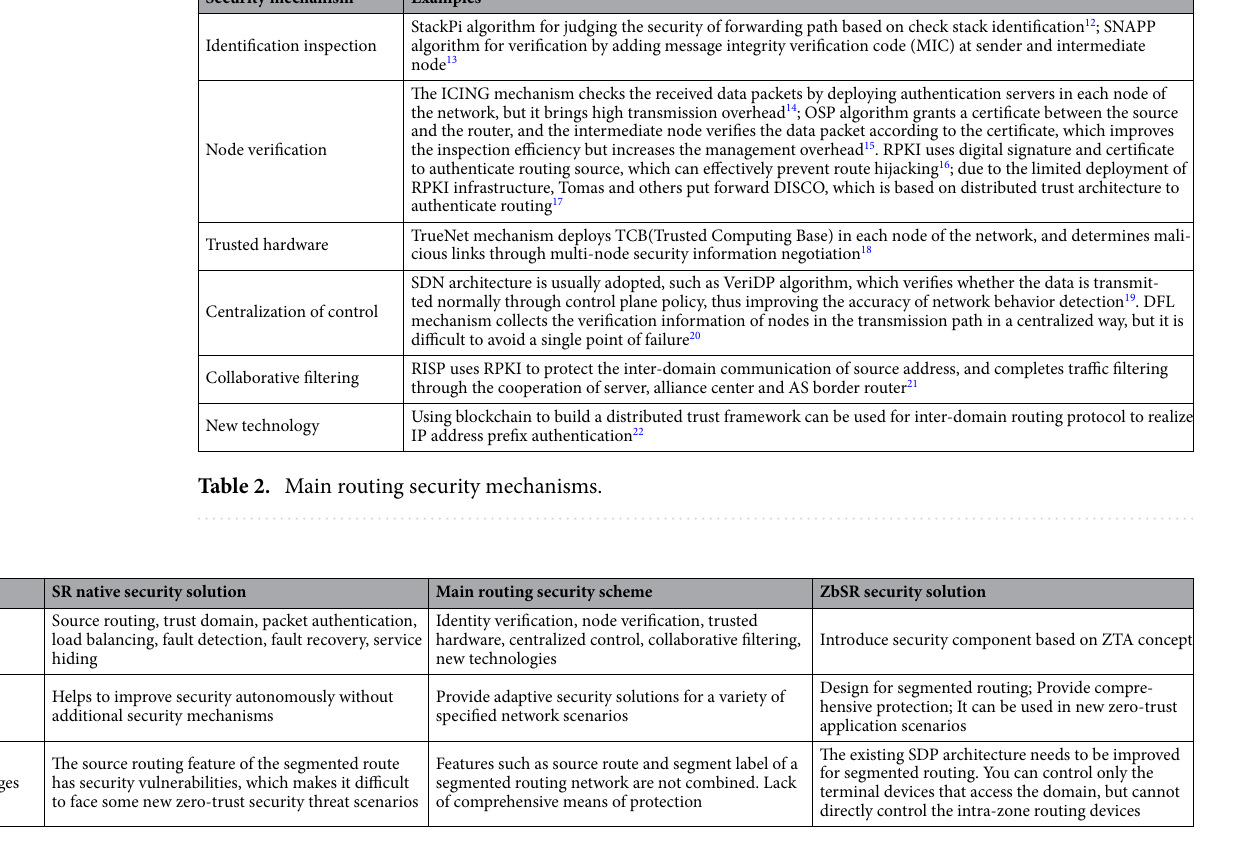
Table 3. Comparison of 3 types of security